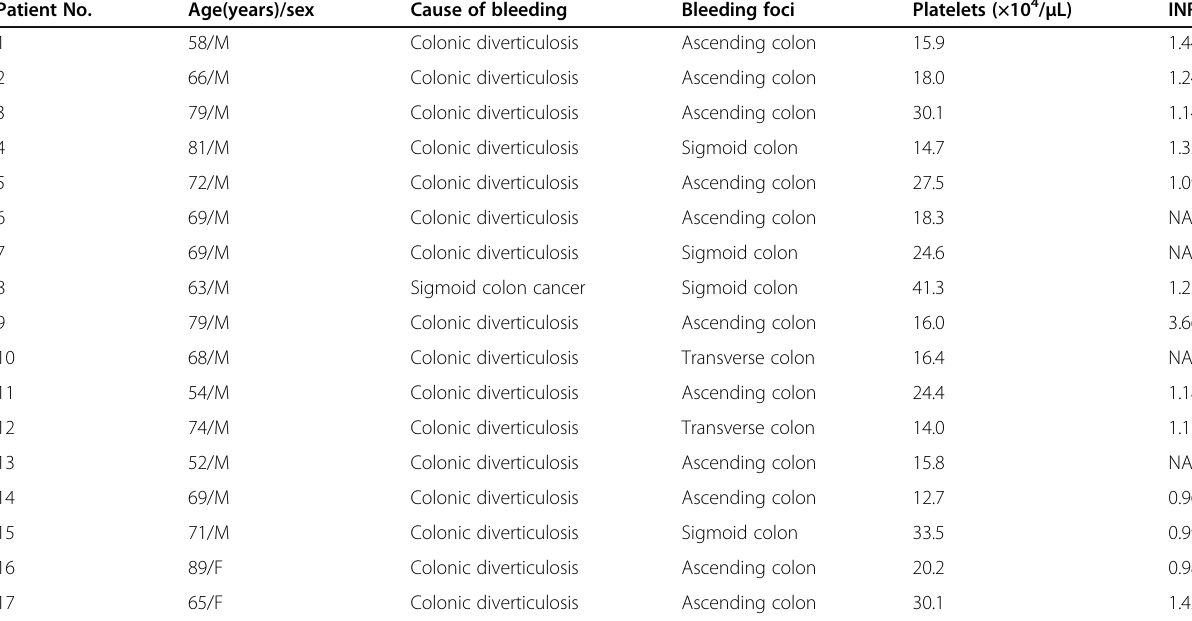
Table 1 The background of the patients Patient